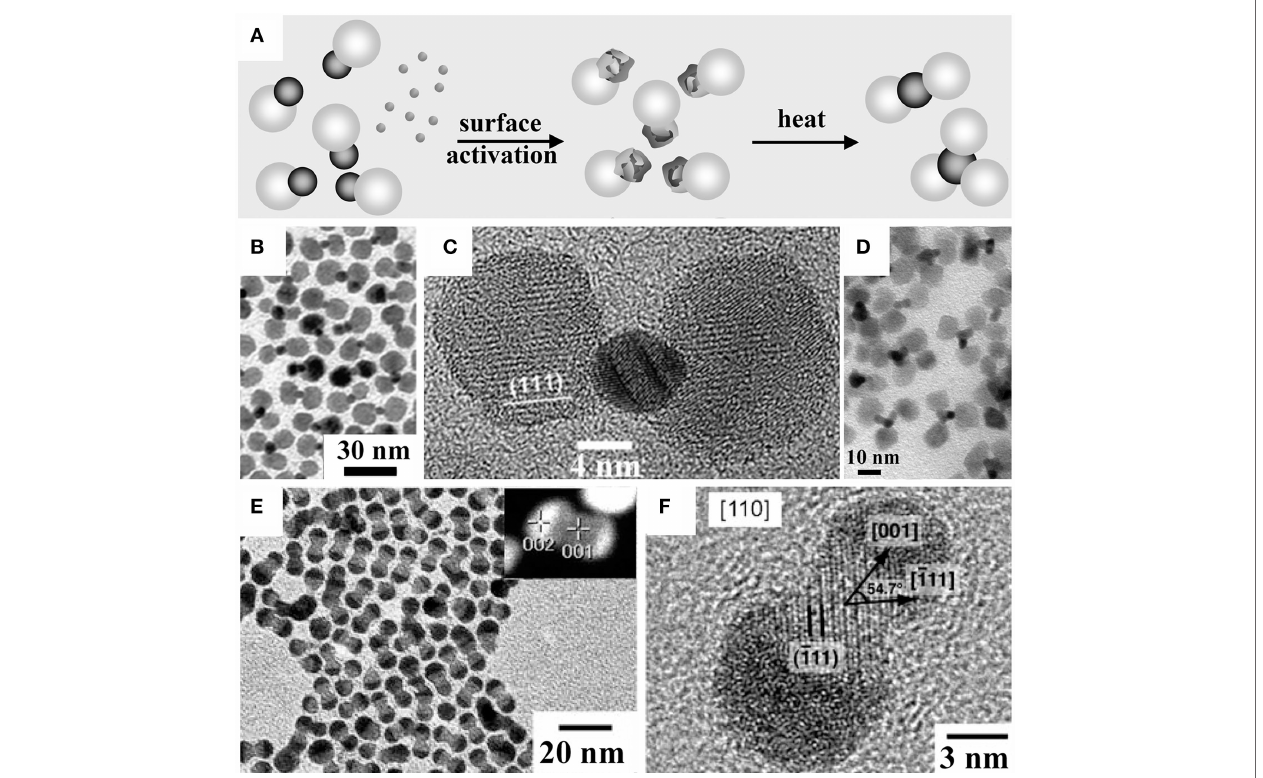
FIGURE 6 | Examples of ternary magnetic heterostructured nanocrystals (MHNCs) synthesized by induced fusion of preformed hetero-dimer seed . ( A ) Sketch of the mechanism [adapted from Casavola et al. (2008) with permission, copyright Wiley-VCH Verlag GmbH & Co. KGaA]. (B–F) Low-resolution transmission electron microscopy overviews and selected high-resolution transmission electron microscopy images of: (B,C) ternary Fe 3 O 4 –Au–Fe 3 O 4 MHNCs with an intermediate Au connecting domain [reproduced from Shi et al. (2006b) with permission, copyright American Chemical Society]; (D) (Fe 3 O 4 –PtPb) n flower-like MHNCs with a central PtPb domain [reproduced from Bradley et al. (2013) with permission, copyright American Chemical Society]; (E,F) ternary PdS x –Co 9 S 8 –PdS x MHNCs with a Co 9 S 8 bridging section [reproduced from Teranishi et al. (2007b), copyright Wiley-VCH Verlag GmbH & Co.